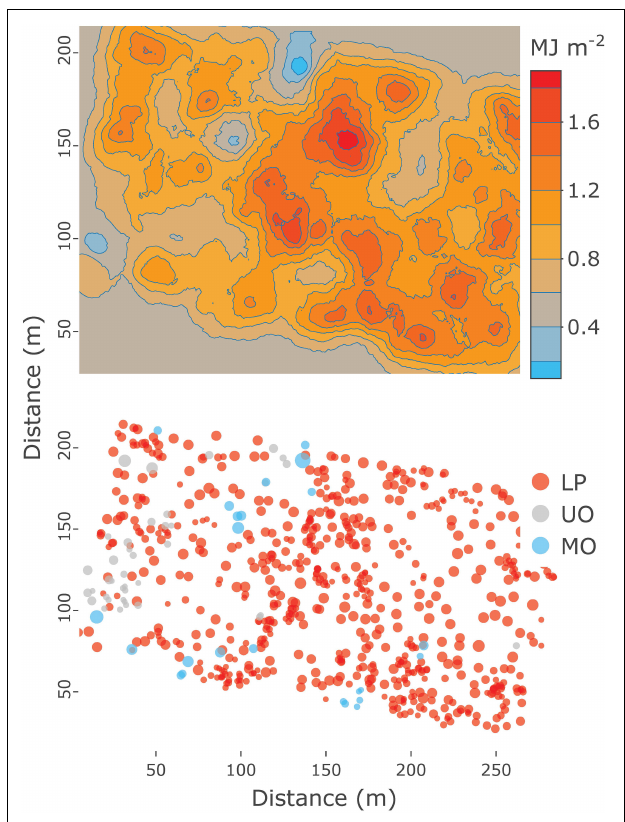
FIGURE 4 | Predicted FRED during dormant-season prescribed fire (top panel) based on DBH, location, and guild of overstory trees (bottom panel) . The lowest AICc model was used for predictions of overstory tree effects (see Tables 5 , 6 ). Symbol size reflects DBH. Abbreviations for tree guilds are: LP, longleaf pine; UO, upland oak; and MO, mesic